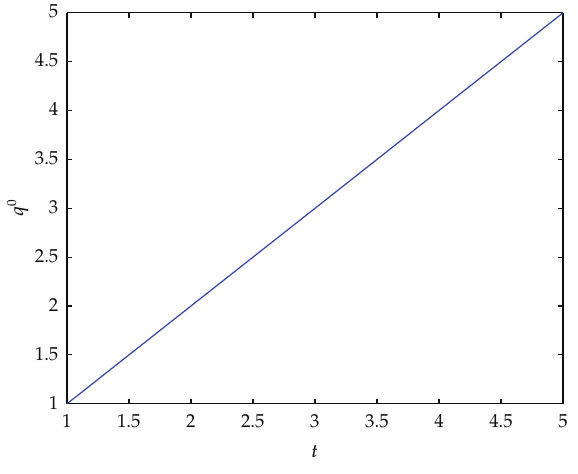
Figure 1: Component q 0 of the geodesic.